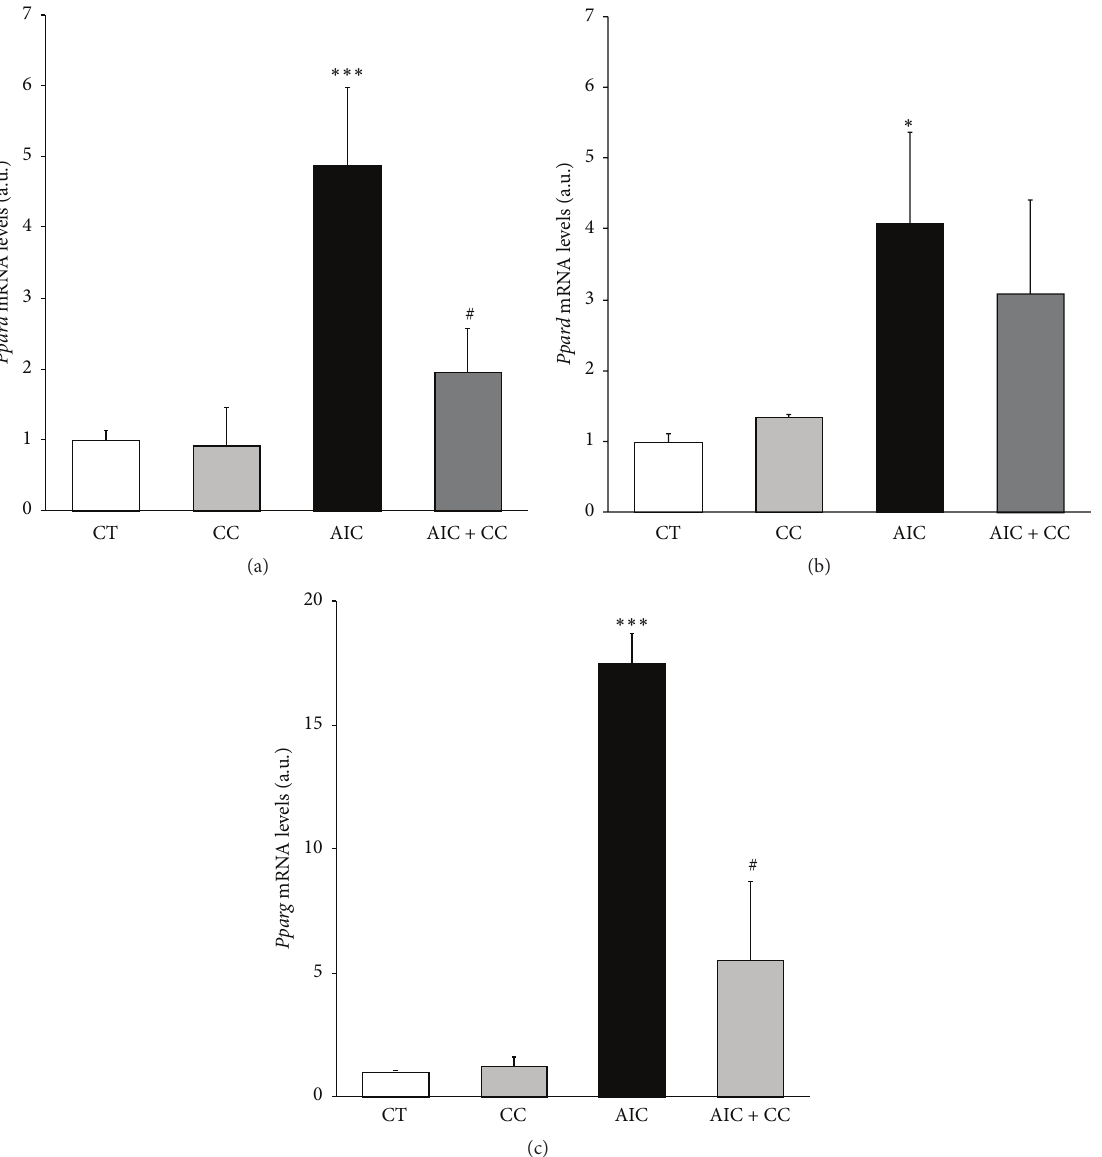
Figure 2: AICAR upregulates the mRNA levels of the three PPARs in HL-1 cardiomyocytes. Analysis of the mRNA levels of Ppara (a), Ppard (b), and Pparg (c) by real-time RT-PCR in HL-1 cells stimulated by AICAR for 24 h in the presence or absence of Compound C. Data are normalized by the Cyclophilin A mRNA levels and expressed as mean ± SD of 4 different experiments. ( ∗ 𝑃 < 0.05 , ∗∗∗ 𝑃 < 0.001 versus control nonstimulated cells; # 𝑃 < 0.05 versus AICAR-treated